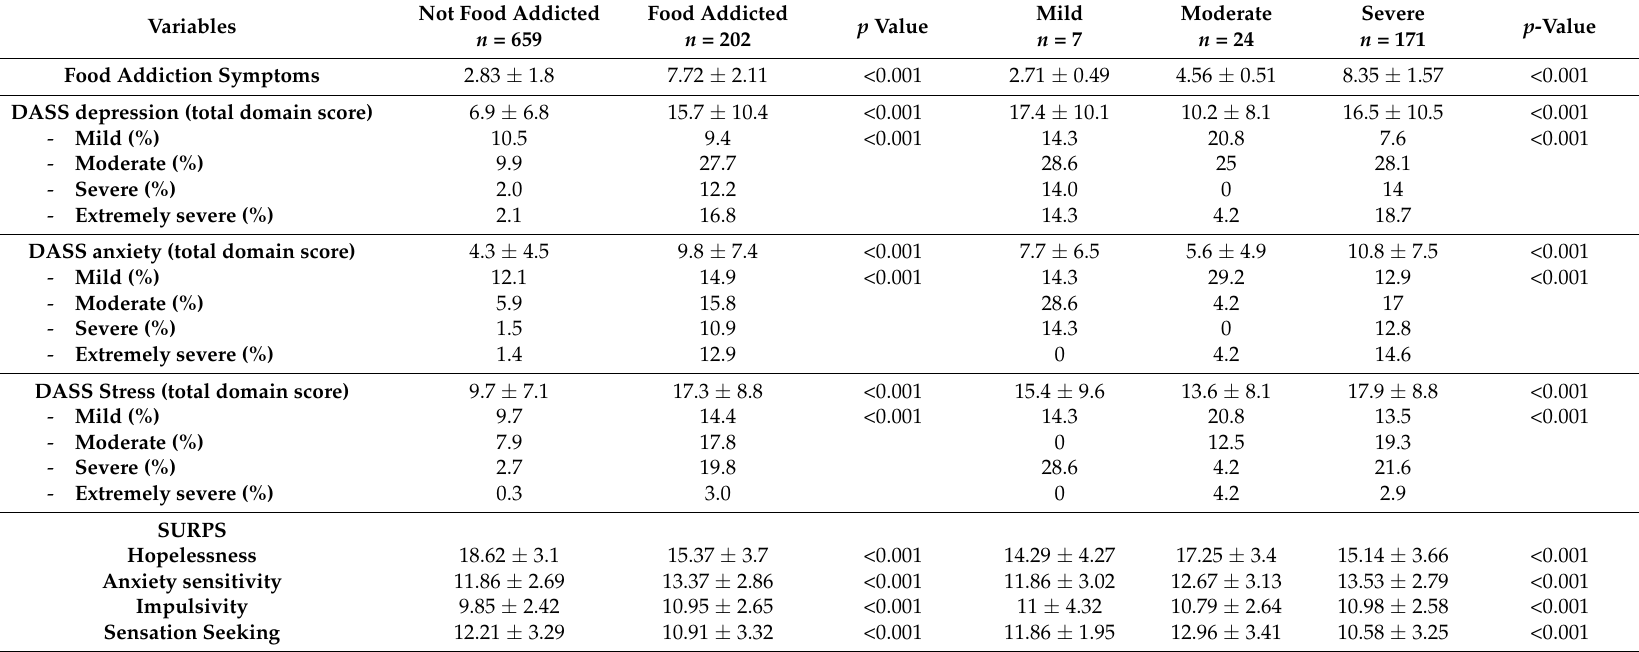
Table 2. Personality traits of Australian adults by food addiction categorisation determined by YFAS.